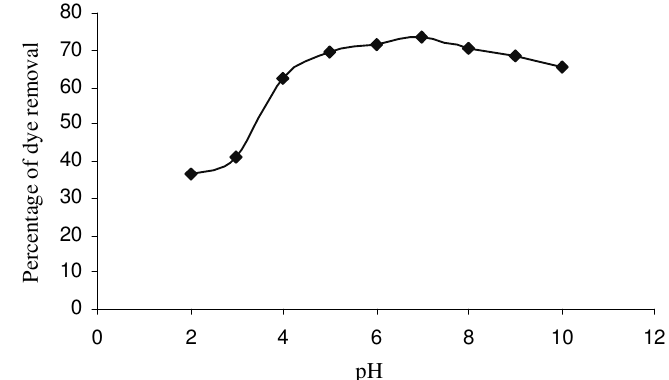
Figure 4. Effect of pH on the removal of Grey BL by Derris leaves powder (concentration 40 mg/L temperature 300 K.